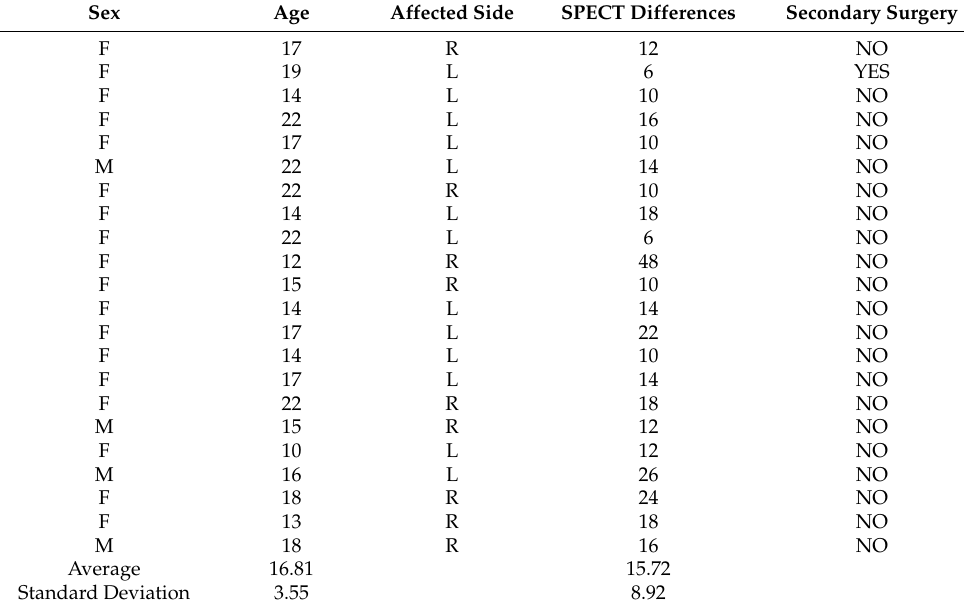
Table 2. Distribution of subjects with UCH according to clinical type